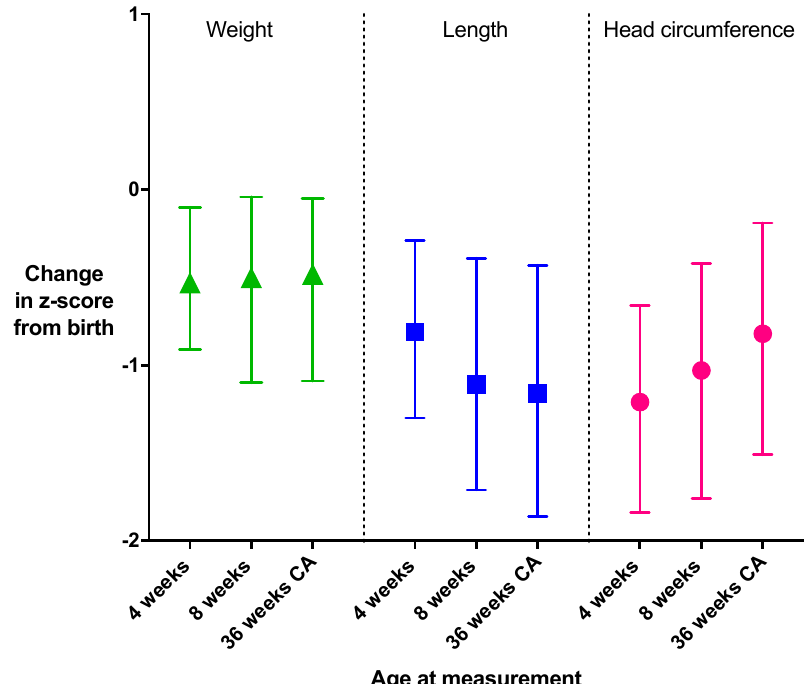
Figure 3. Change in z-score from birth for weight, length and head circumference. Change in z-score for the overall cohort at each time point from birth (median and interquartile range). n : 4 weeks, weight n = 344, length n = 323, head circumference n = 339; 8 weeks, weight n = 343, length n = 334, head circumference n = 339; 36 weeks’ corrected age, n = 369, length n = 346, head circumference n = 339. Expected growth (z-score change >-0.8 to <0.8) is indicated by the grey shaded area. CA, corrected age.